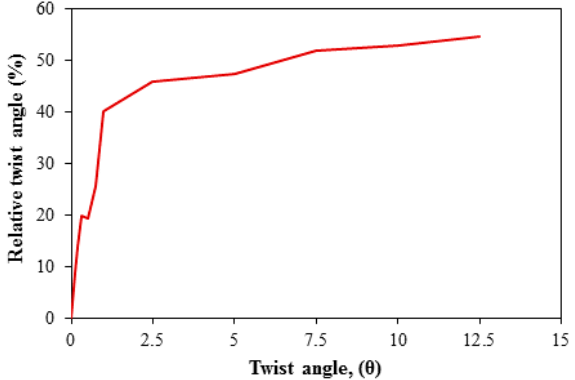
Figure 10. Relative twist angle across different twist angles.